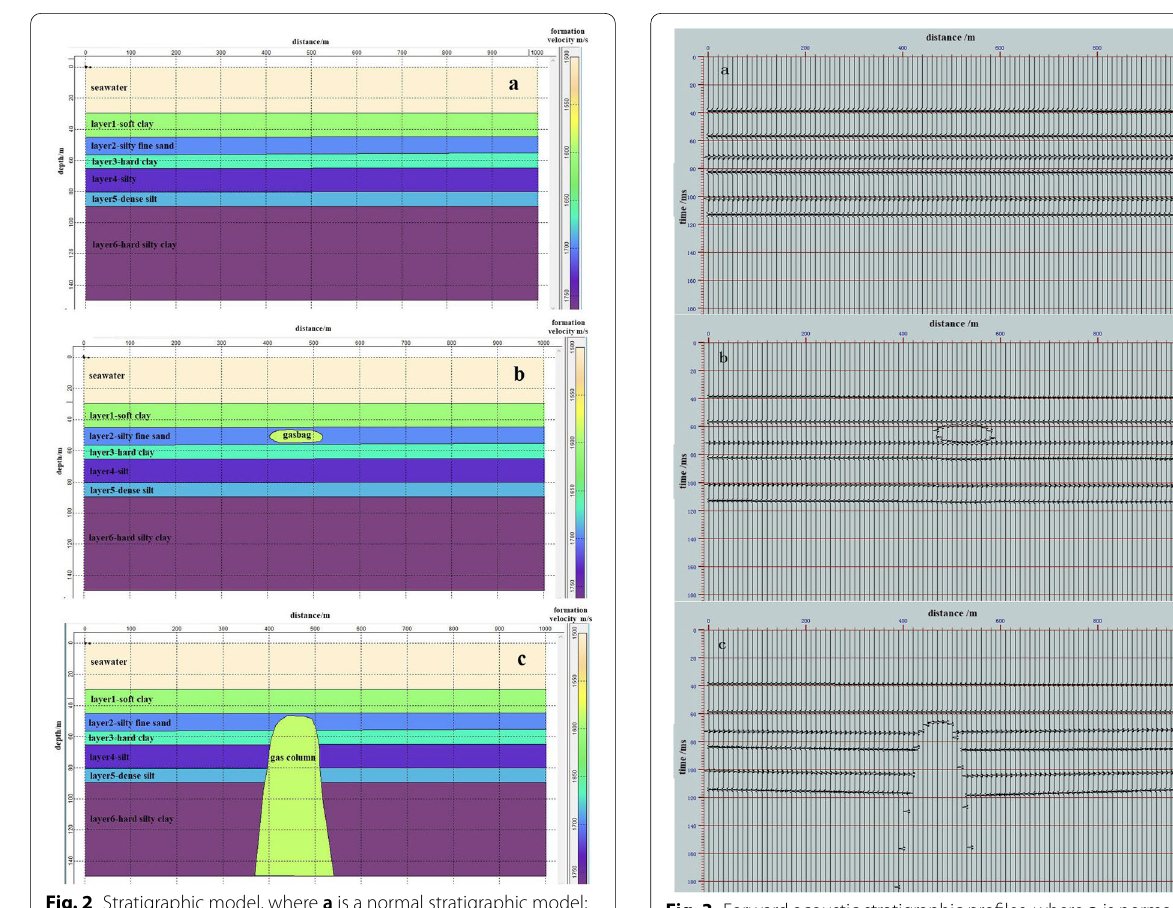
Fig. 3 Forward acoustic stratigraphic profiles, where a is normal stratigraphic model; b is a biomethane shallow gas model; and c is a